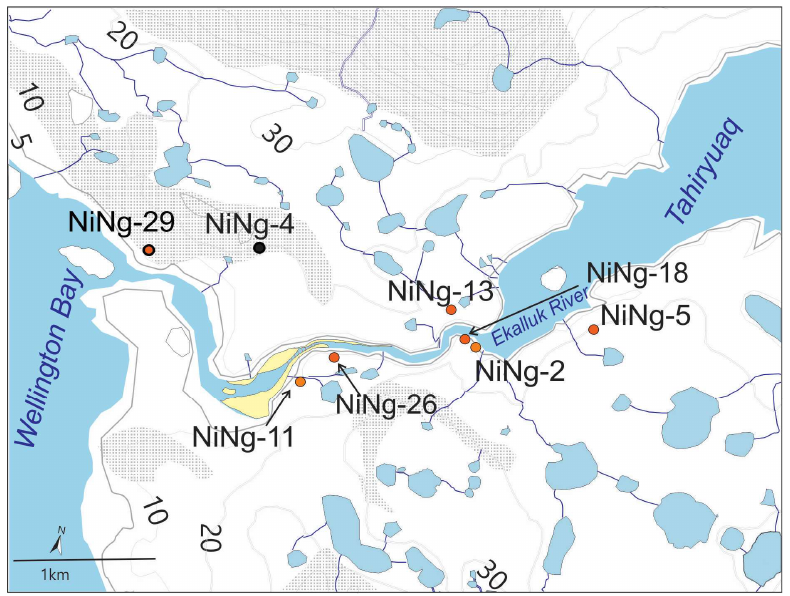
Figure 8. Thule/Inuit (550 cal B.P to present) site location situated on modern landscape. Yellow indicates possible sand bars.